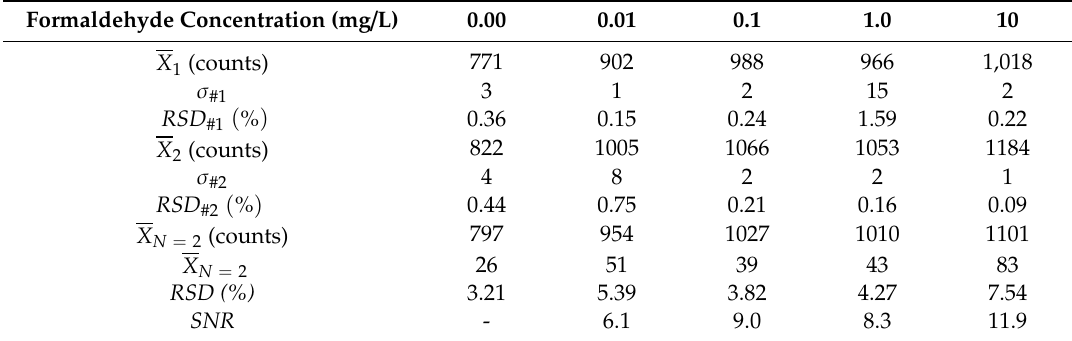
Table 2. Error distribution as the standard deviation ( σ ), relative standard deviation (RSD), and signal-to-noise ratio (SNR) for the silicon fluidic cell at the excitation optical power P = 315 mW, where #1 and #2 represented the two independently prepared samples for each of the tested concentrations c i for i = 0, ... ,